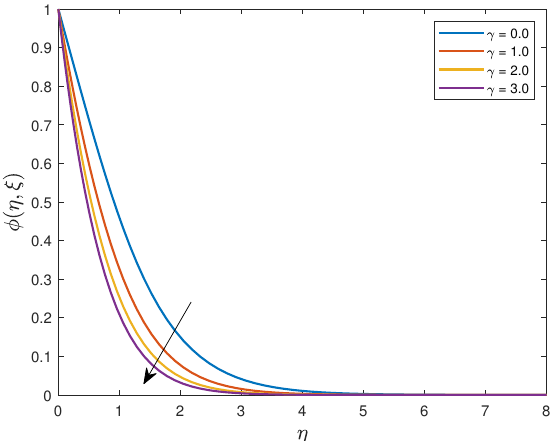
Figure 21. The influence of γ on fluid